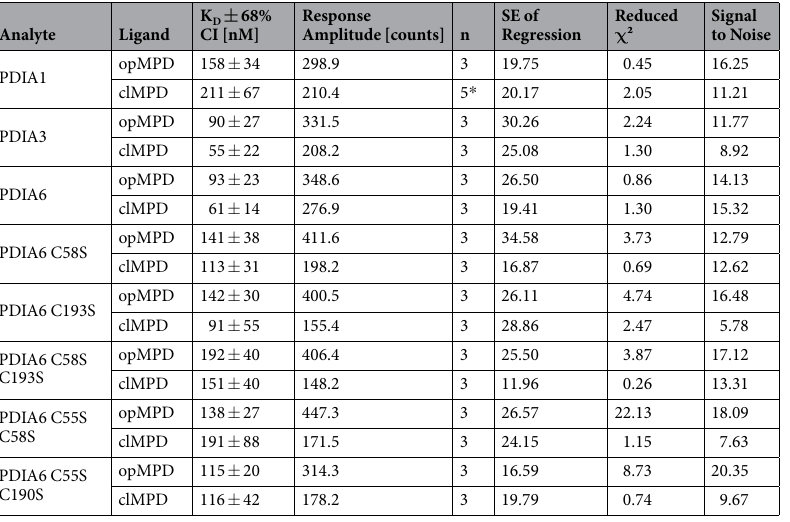
Table 2. Dissociation constants (K D ) of the PDI-MPD interaction with 68% confidence interval (CI) obtained by fitting the data from at least 3 independent MST analyses each with sixteen dilutions (1:2 dilution series) of the respective PDI at 25 °C. K D ’s were calculated from the concentration-dependent ligand induced fluorescence intensity changes according to Eq. 1. Additional parameters resulting from the fit: Response amplitude of the fluorescence intensity shift between bound and unbound state, standard error (SE) of regression, reduced χ ² and signal to noise. * Replicates increased to 5 due to variations at low concentration.